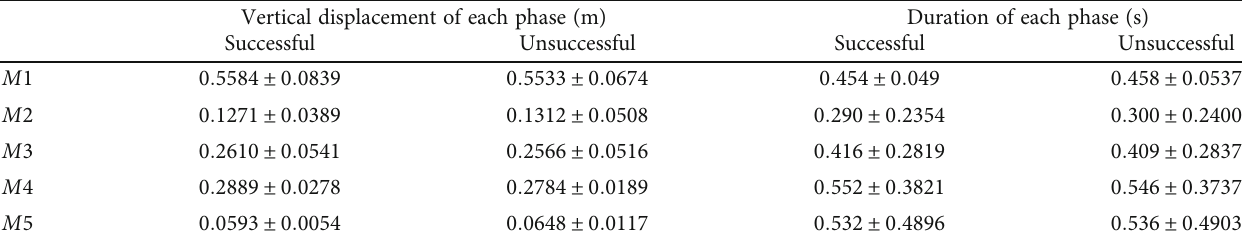
Table 3: Vertical displacement of barbell and time duration of each phase of the successful and unsuccessful snatch.